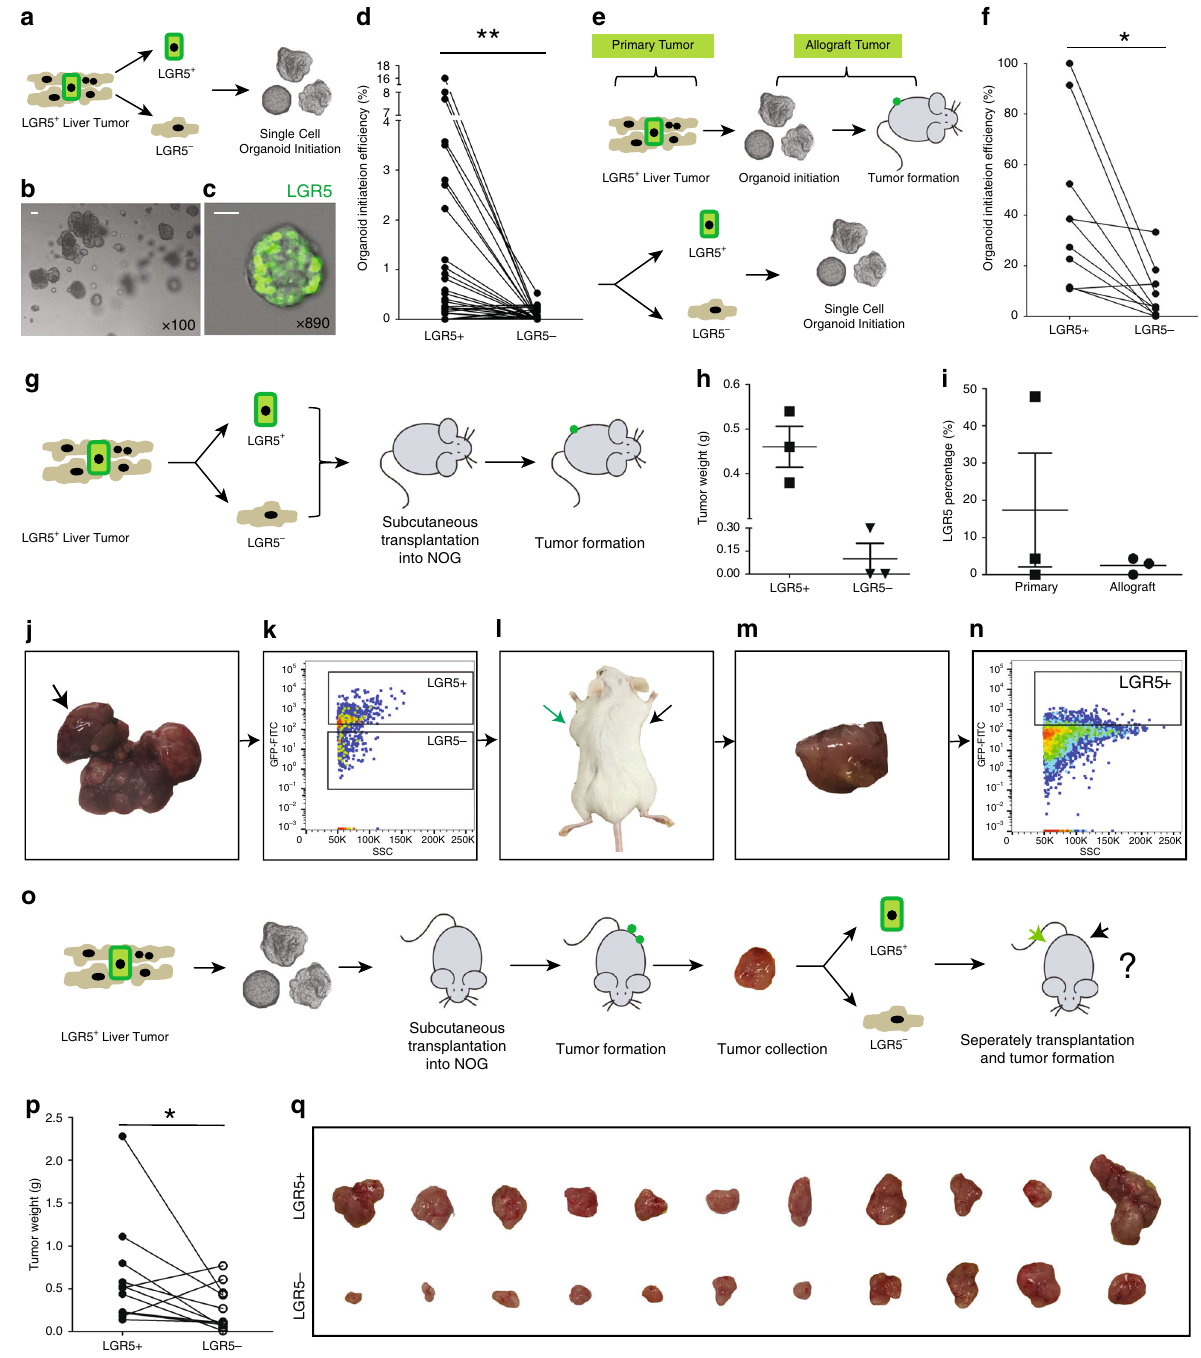
proliferation (Fig. 6a, b), and sorafenib treatment served as a positive control. DT treatment inhibited the growth of tumor organoids in an effect that showed close correlation as to the effects on the numbers of LGR5 – GFP + cells (Fig. 6c – e). DT treatment did not in fl uence the growth of tumor organoids of genetically wild-type (Fig. 6c: left panel). We further assessed therapeutic targeting of LGR5 liver cancer cells in vivo. We fi rst evaluated the effect of DT treatment after formation of visible tumors, following trans- plantation of tumor organoids into immunode fi cient mice (Supplementary Fig. 10a). 5-FU and sorafenib served as